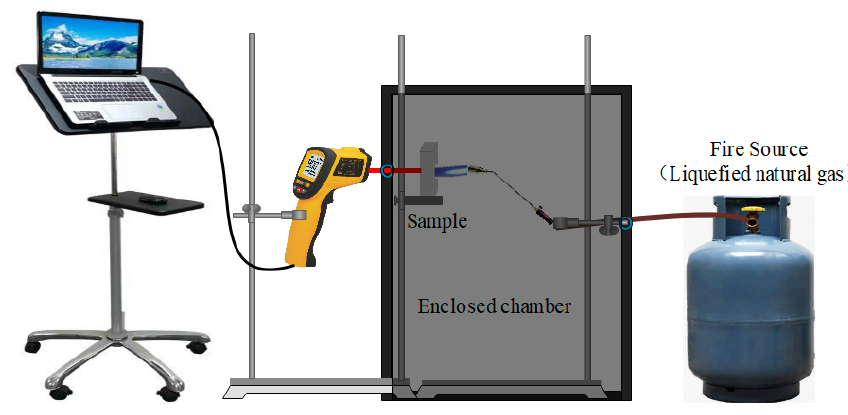
Figure 2. The setup for fire-resistance test.